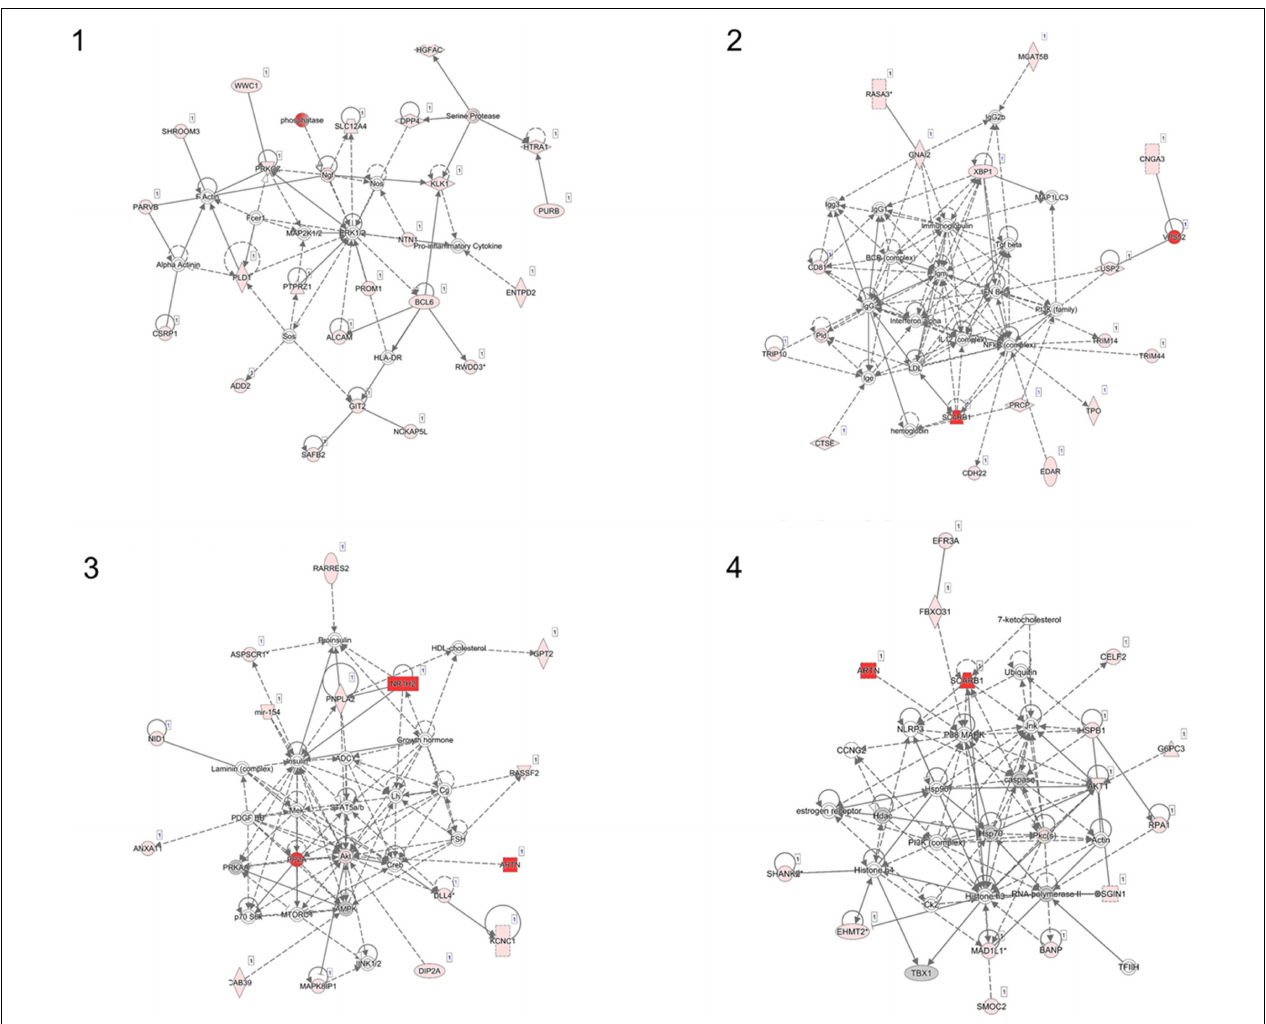
FIGURE 2 | Ingenuity pathway network analysis (IPA) using top 248 CpG sites (network 1–4). Four networks identified with Ingenuity Pathway Analysis. (1) Cell morphology, cellular assembly, and organization, nervous system development and function; (2) Antimicrobial response, humoral immune response, infectious disease; (3) Carbohydrate metabolism, molecular transport, small molecule biochemistry; (4) Cancer, cell death and survival, DNA replication, recombination and